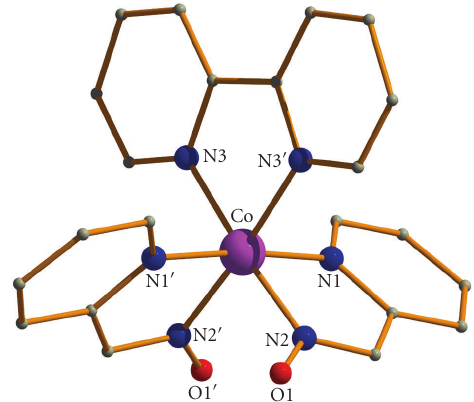
Figure 4: Partially labeled plot of the molecular structure of the cation that is present in 2 · 1.5MeOH. H atoms have been omitted for clarity. Primes are used for symmetry related